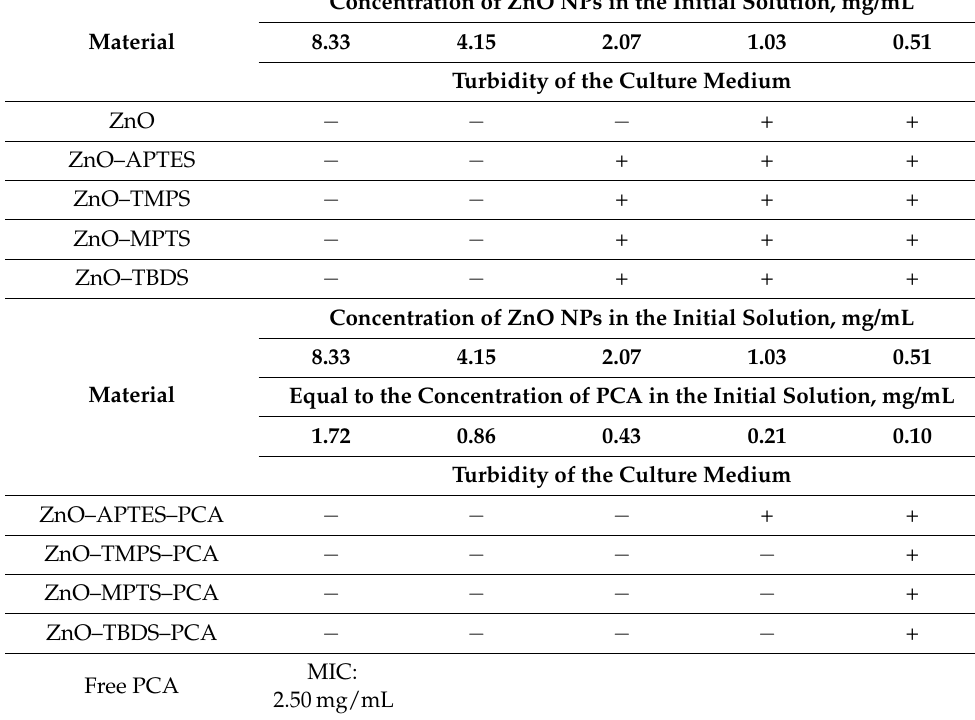
Table 3. Biological activity of surface-modified ZnO NPs and nanoformulations consisting of the PCA